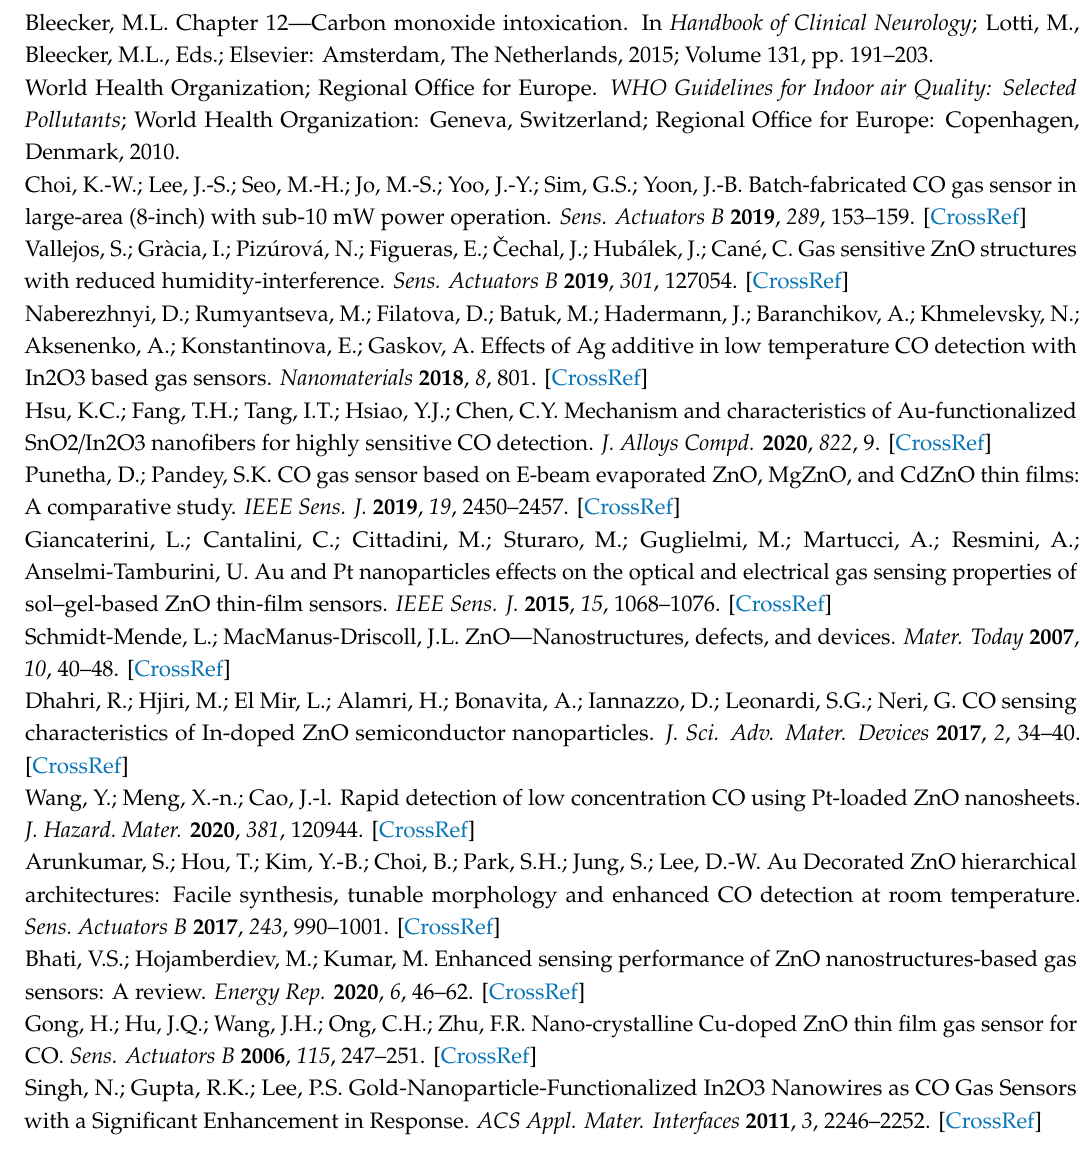
Figure S1: SEM image of ZnO nanostructures ( a ) ZnO nanorod ( b ) ZnO nanoplate, Figure S2: XRD patterns of the